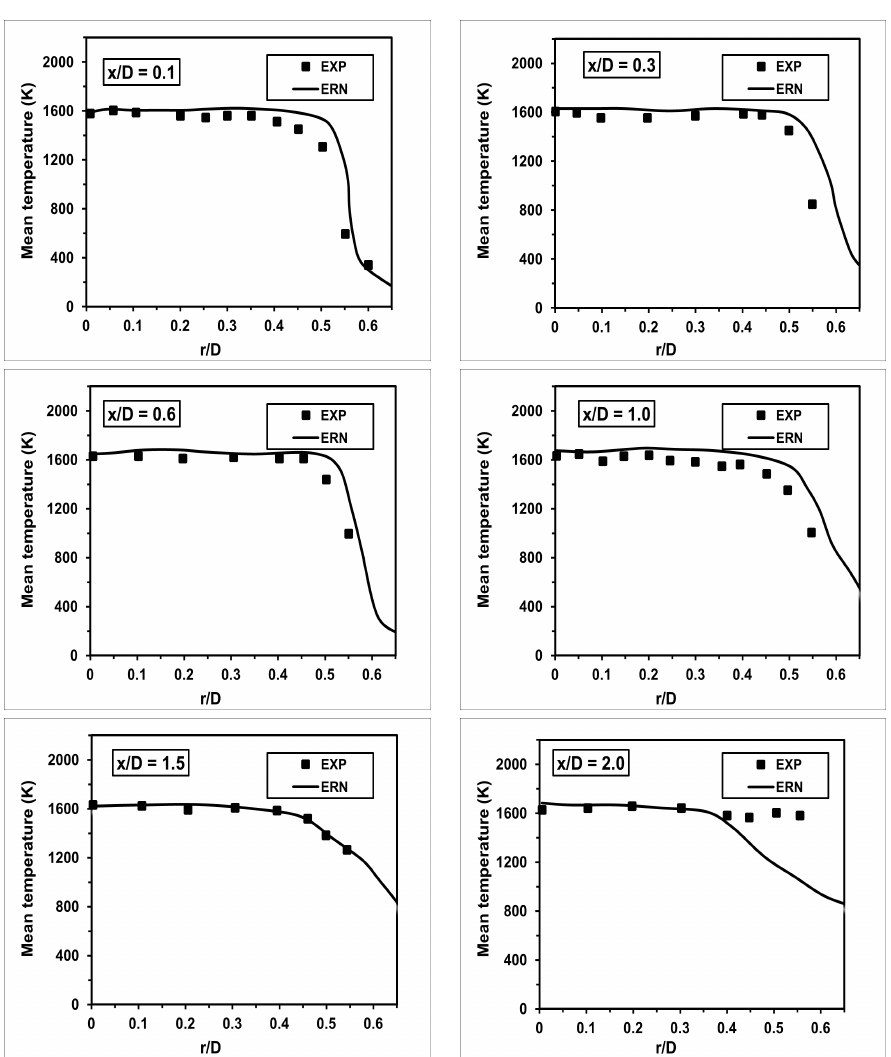
Figure 7. The computed mean temperature is compared to the experimental measurements at axial locations x / D : 0.1, 0.3, 0.6, 1, 1.5, and 2.